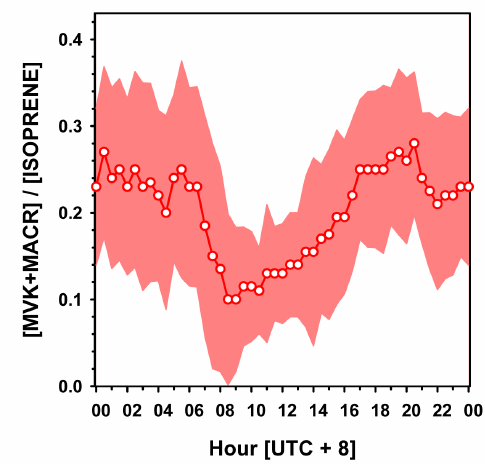
Fig. 5. Average diurnal profile of the MVK+MACR:isoprene ratio during